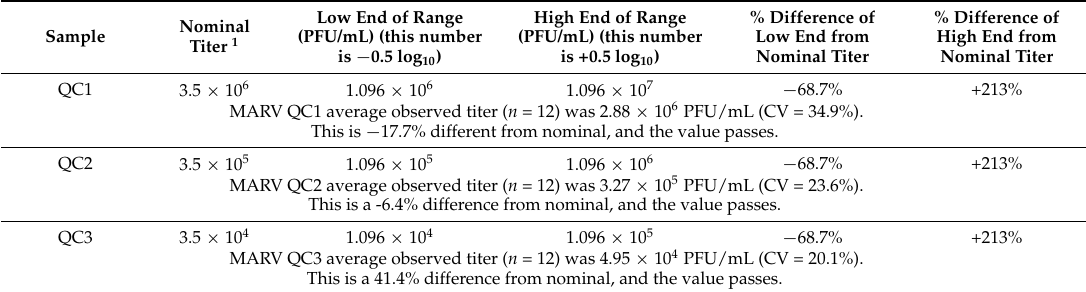
Table 2. Marburg Virus (MARV) accuracy results in the context of the ranges of acceptable low and high % differences for both sets of QC1, QC2 and